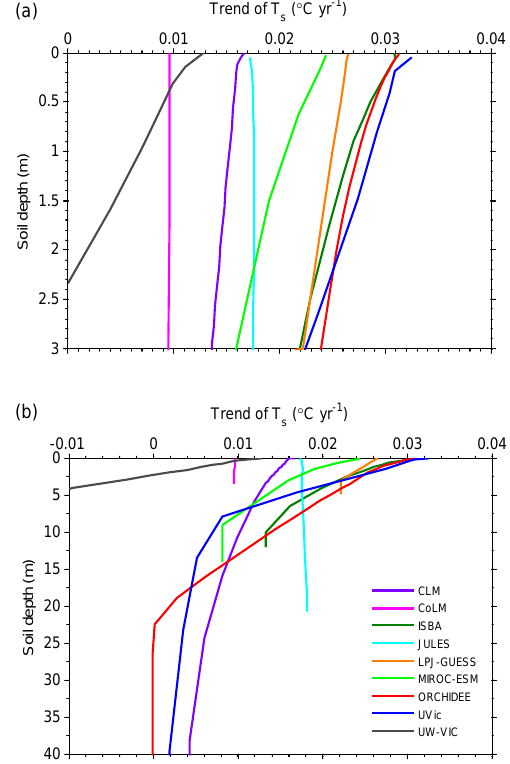
Figure 5. Simulated trends of annual T s over boreal regions as a function of soil depths (a) 0–3m and (b) 0–40m for the nine mod- els. Note that the different total soil depths of the models and neg- ative trends for UW-VIC ( ∼− 0.01–0.03 ◦ Cyr − 1 ) below 2.3m are not shown in the